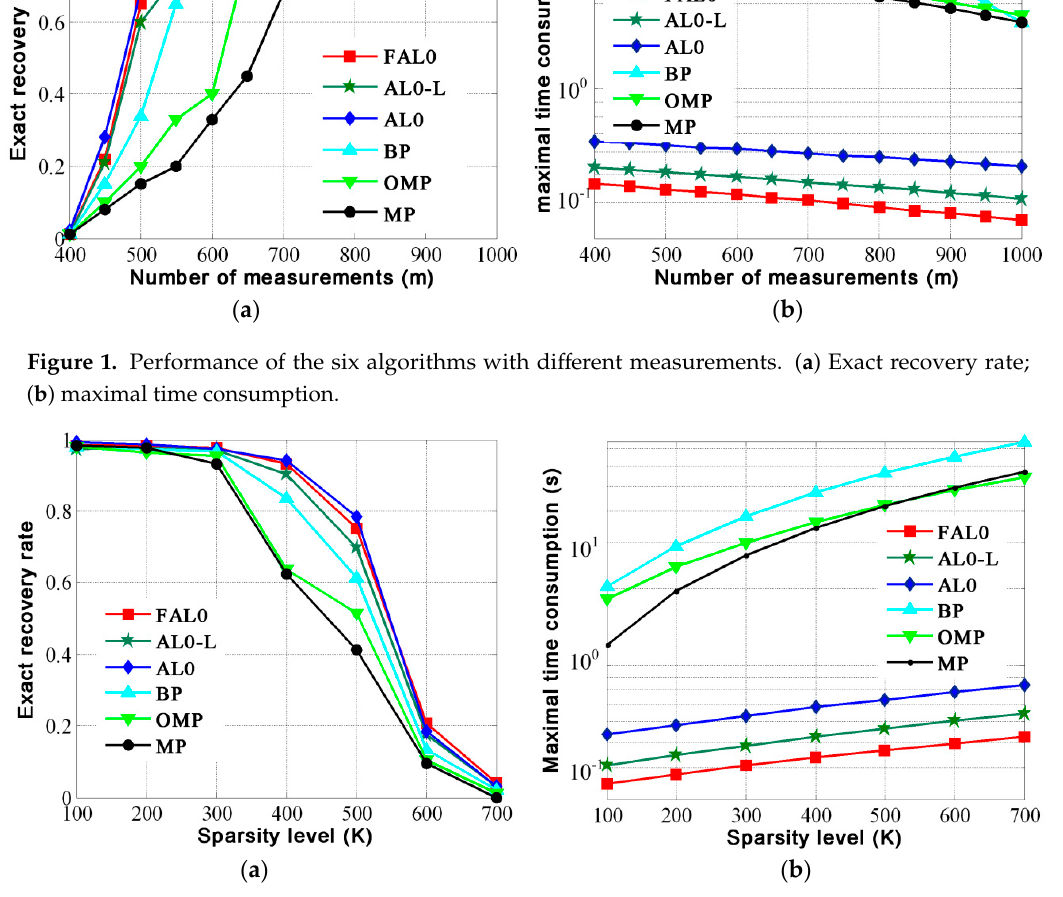
Figure 2. Performance of the six algorithms with different sparsity levels. ( a ) Exact recovery rate; ( b ) maximal runtime time consumption.